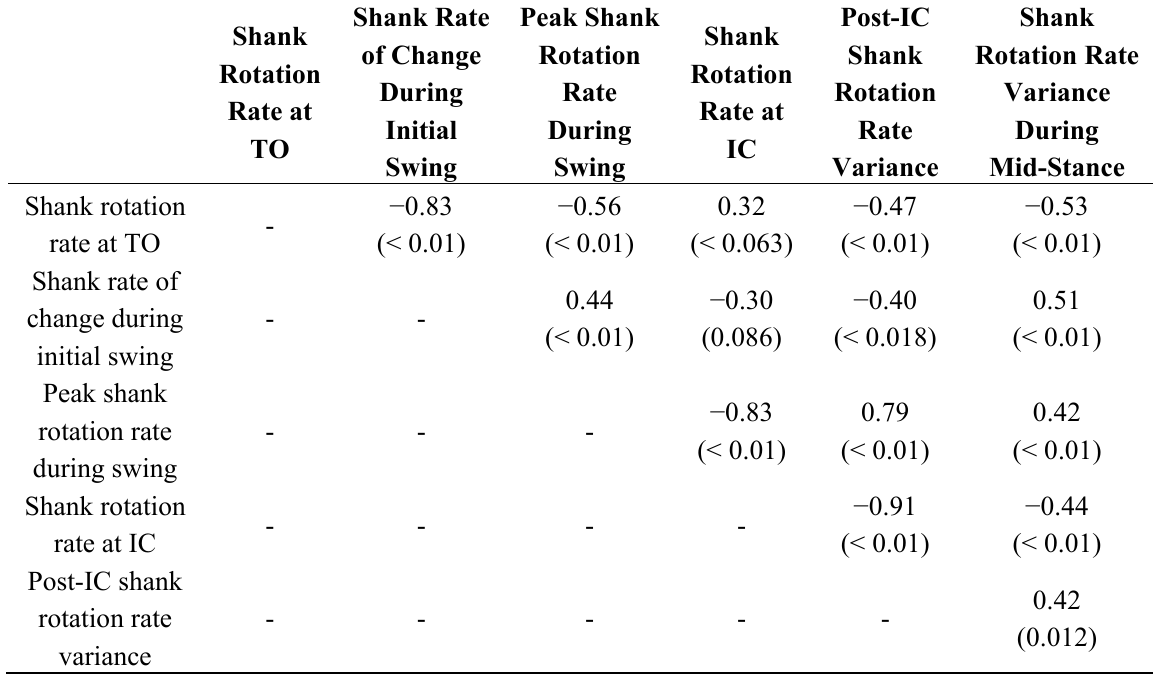
Table 4. Pearson product correlations and significance values (presented in brackets) between each of the gyroscope extracted